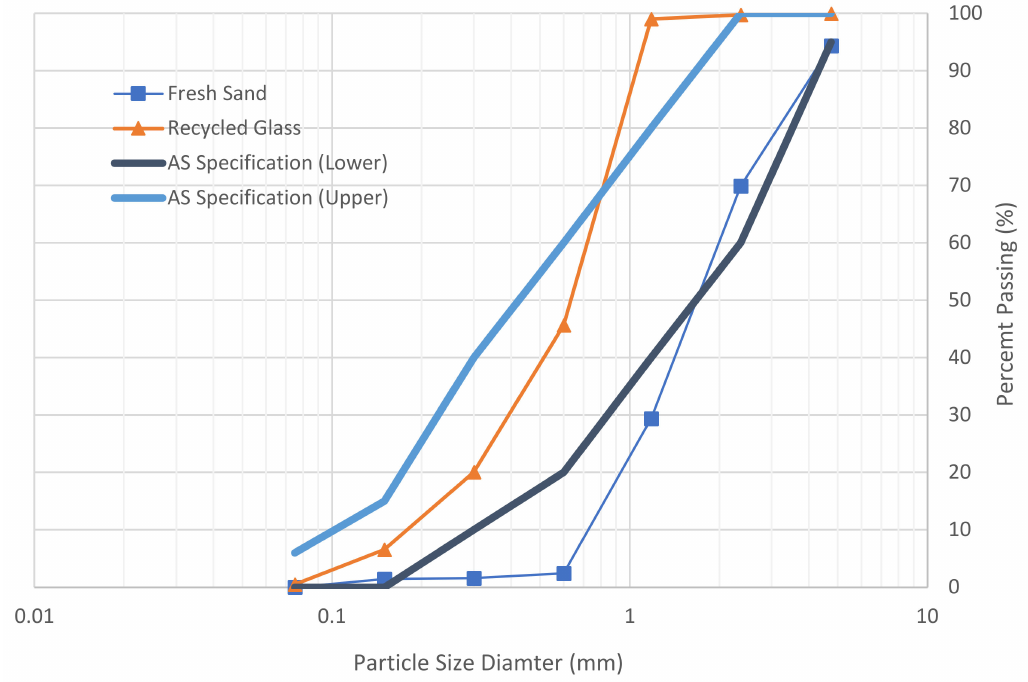
Figure 5. Size distribution curve for the fine aggregates used. Limits according to Australian Standards (AS 1141)